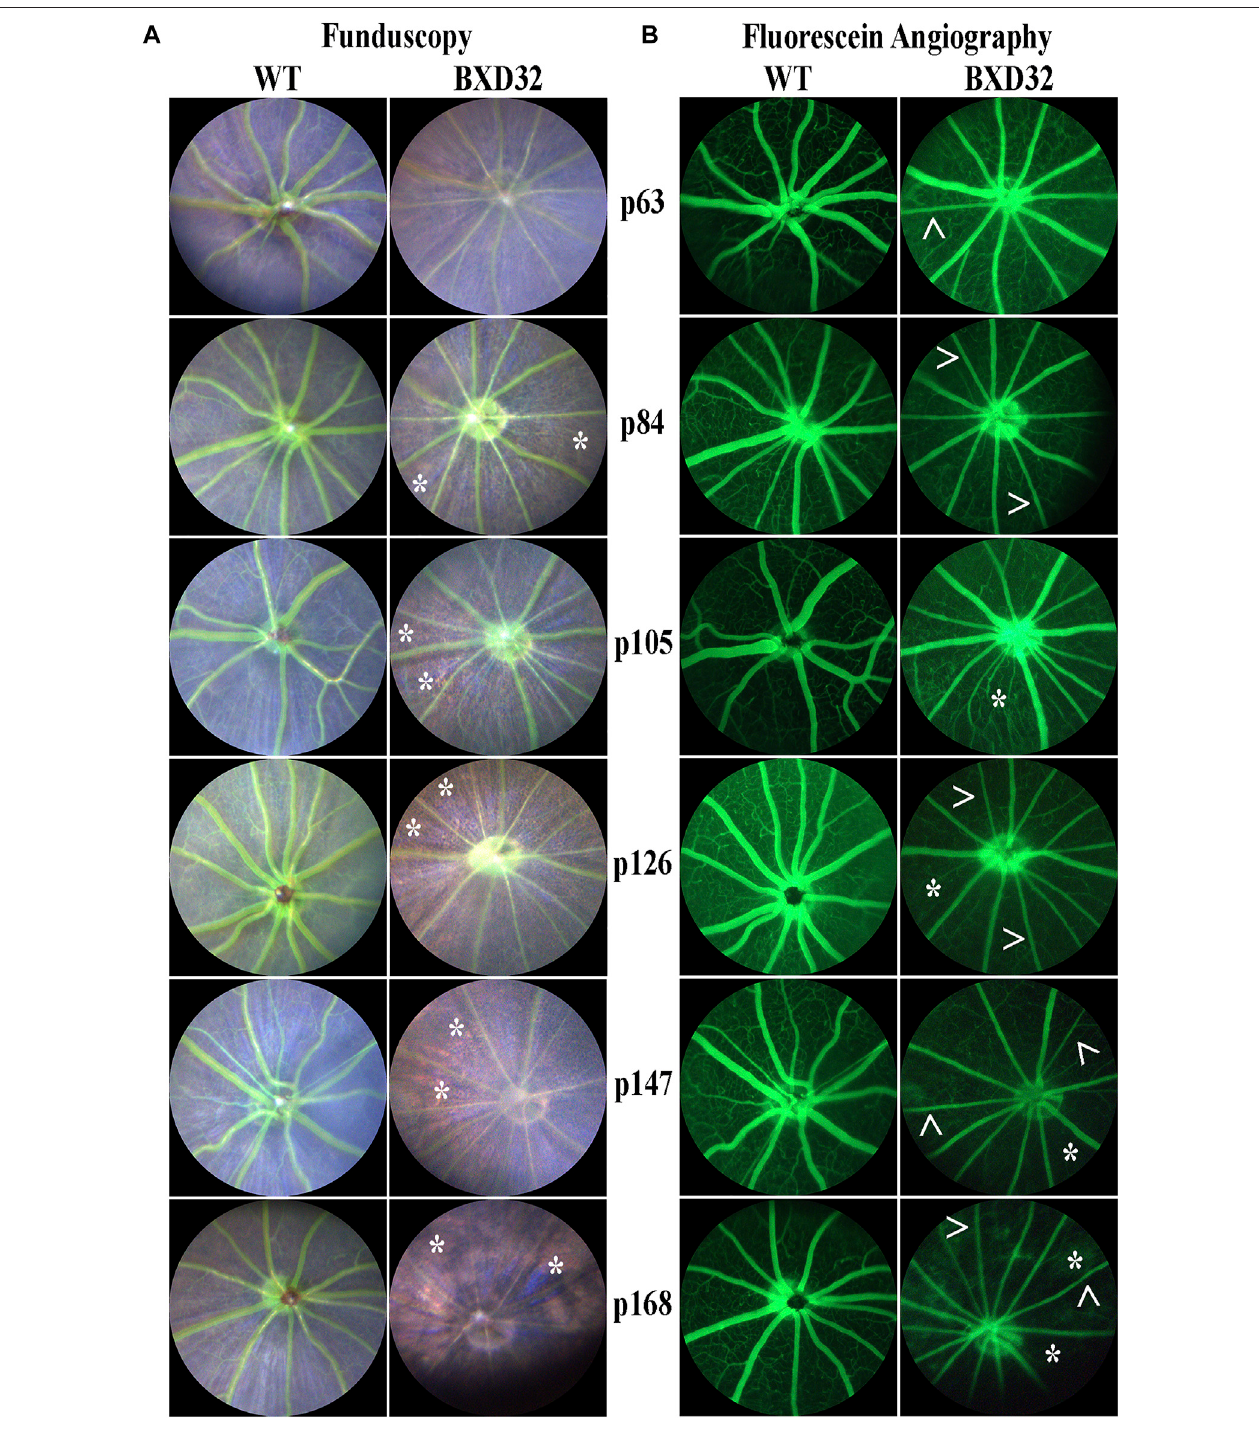
FIGURE 3 | Funduscopy and fl uorescein angiography reveal retinal phenotypes consistent with RP. WT and BXD32 retinas were observed under white light for funduscopy (A) and using 488 nm for fl uorescein angiography (B) light post- fl uorescein injection. By funduscopy, BXD32 mice as early as p84 begin showing RPE through the neural retina (asterisks, *) indicating a major loss of photoreceptors in these regions. Fluorescein angiography reveals vessel attenuation in the super fi cial vascular plexus (arrowheads, > ) beginning around p63 with some regions exhibiting vaso-obliteration, mostly in the intermediate and deep vascular plexi (asterisk,